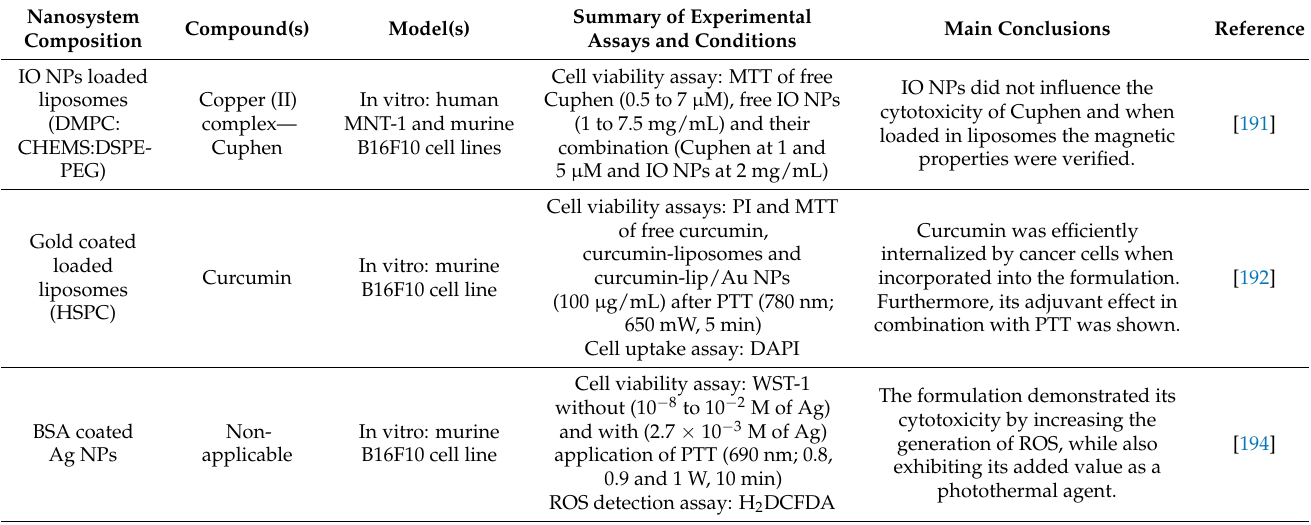
Table 6. In vitro and in vivo assessment of the therapeutic potential of different hybrid nanoparticles in melanoma